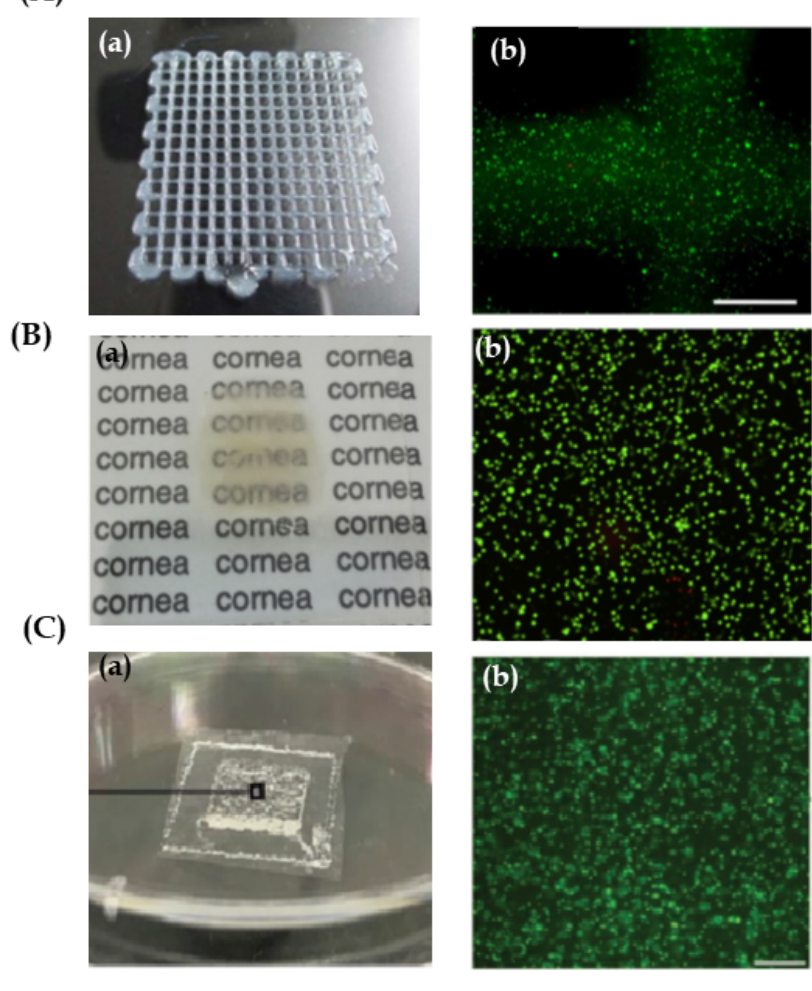
Figure 5. ( A ) Reproduced with permission from [45], Nature, 2016. Cornea epithelial structures: ( a ) Top view of a 3D human corneal epithelial cells/gelatin/alginate construct. ( b ) Epithelial cell viability after extrusion bioprinting by live/dead staining, showing live (green) and dead (red) cells. Scale bar 500 µ m. ( B ) Reproduced with permission from [32], Elsevier, 2018. Cornea stroma and epithelium structure. ( a ) 3D bio-printed cornea from human embryonic stem cells and human adipose tissue derived stem cells fabricated onto supportive membrane using laser-assisted bioprinting. This shows moderate transparency. ( b ) Cell viability of human embryonic stem cells seven days after printing shown with live-dead-staining. Live cells are visualized with green and dead cells with red. Scale bar 1 mm. ( C ) Reproduced with permission from [46], Wiley, 2019. Cornea endothelium structures. ( a ) Image of the bio-printed genetically modified human corneal endothelial cells (HCECs)/gelatin scaffold on an amniotic membrane. ( b ) The seeded live HCECs were densely and evenly distributed just after bioprinting. Scale bar: 500 µm.